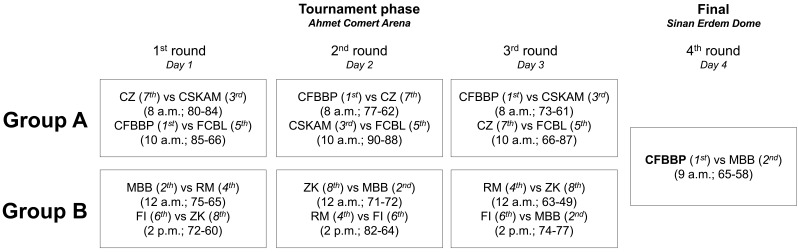
Diagram to show the match distribution throughout the tournament.